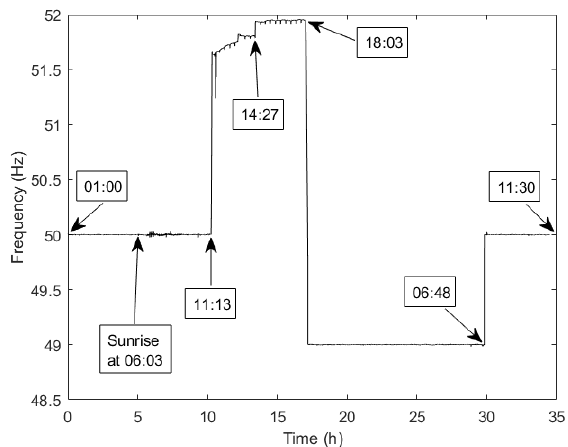
Figure 3. Frequency variations in the nanogrid from April 15th 2017 01:00 to 11:30 the 16th of April 2017.